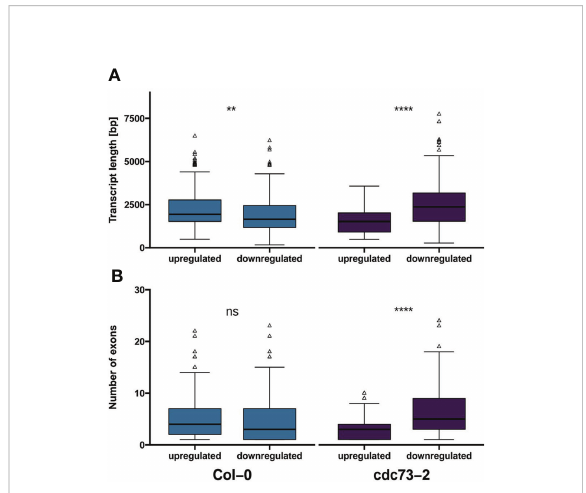
FIGURE 6 Transcript length and number of exons of genes uniquely differentially expressed in Col-0 or cdc73-2 . (A) average transcript length of genes differentially expressed either in Col-0 or cdc73-2 . (B) number of exons of genes differentially expressed either in Col-0 or cdc73-2 . Data was evaluated using Wilcoxon signed-rank test (**, p ≤ 0.01; ****, p ≤ 0.0001; ns, not signi fi